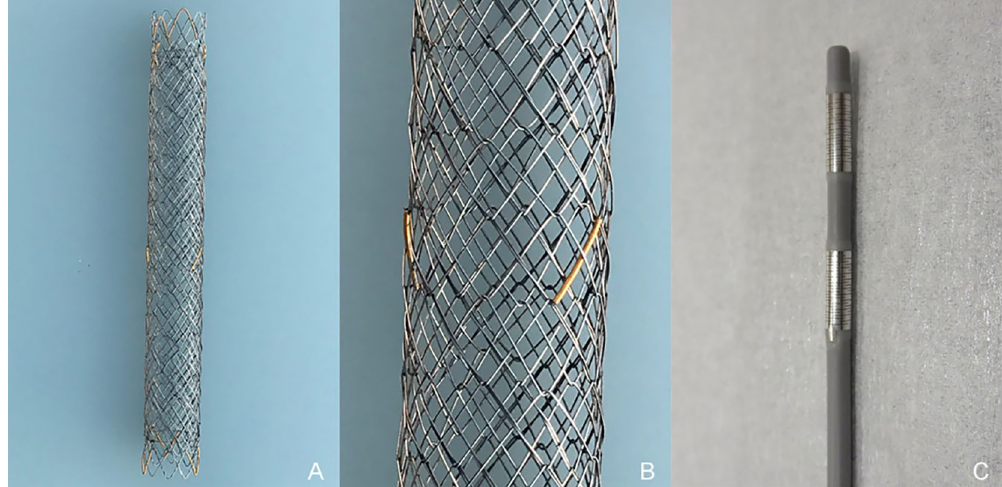
Figure 1. The structure of the EGIS biliary double bare stent (S&G Biotech, Seoul, Korea) is composed of two cross-overlapping standard uncovered stents, which can reduce the cell size and ensure sufficient radial force ( A,B ). The Habib EndoHPB catheter (Boston Scientific, Marlborough, MA, USA) is a bipolar catheter specializing in endobiliary radiofrequency ablation with two 8-mm ring electrodes placed 8-mm apart at the catheter tip ( C